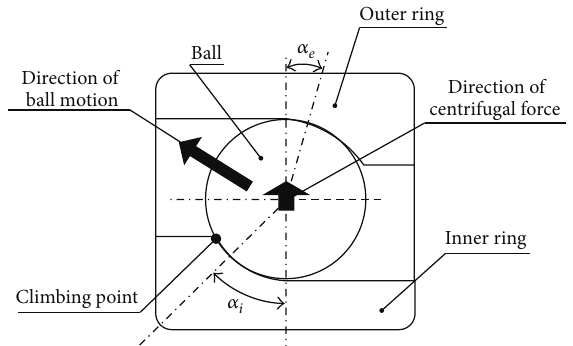
Figure 18: Microgeometry of angular contact ball bearing in operational state.